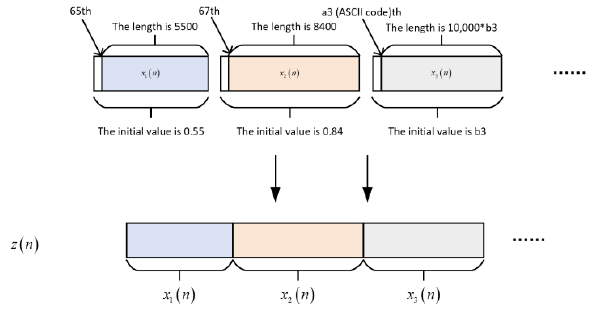
Figure 4. Sequence generation